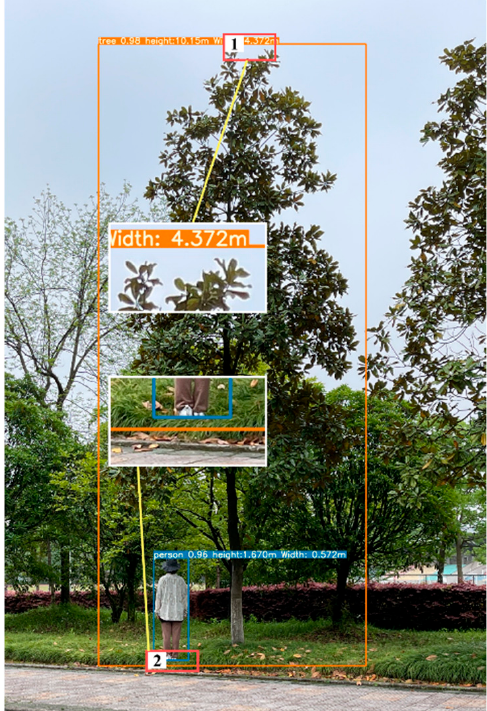
Figure 13. The result for YD4. Box 1 and box 2 mark the main sources of error.